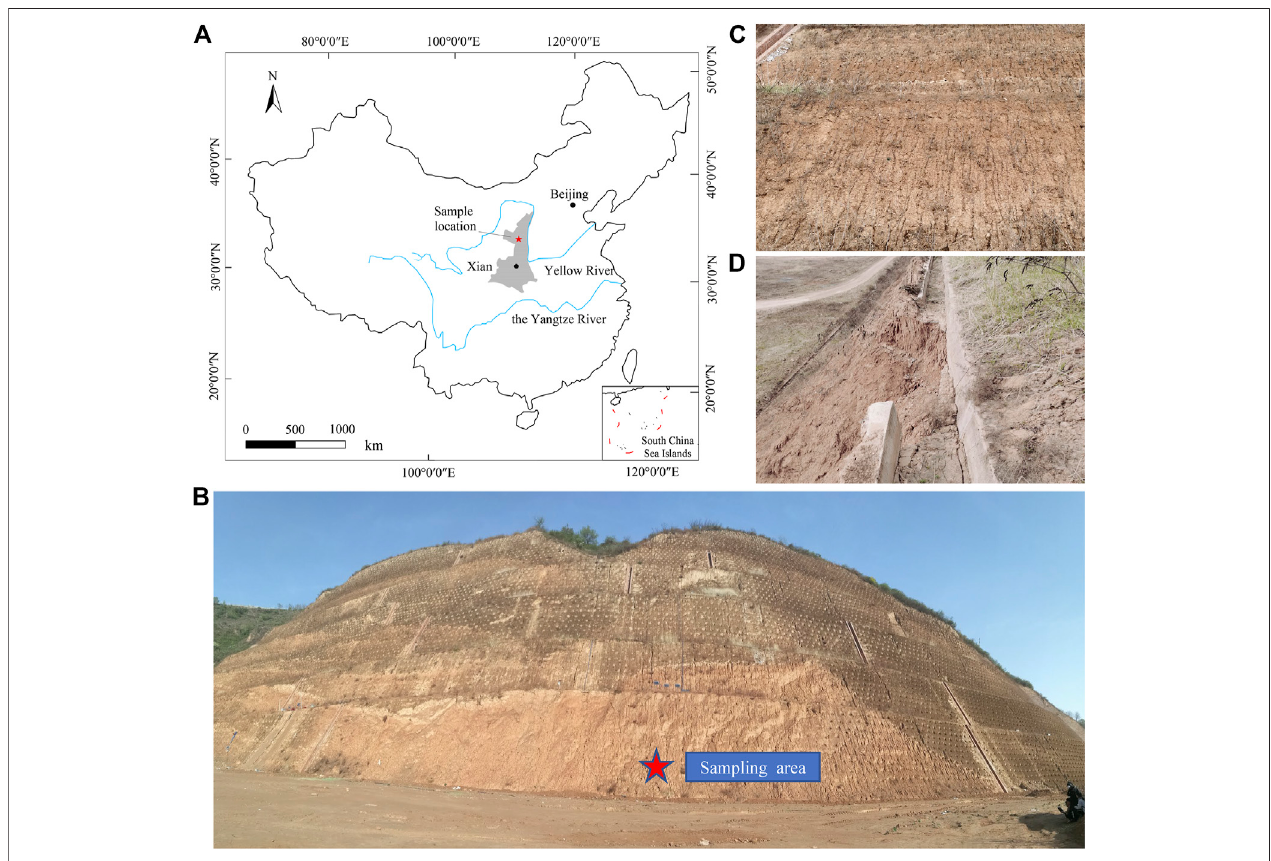
FIGURE 1 | Soil erosion on loess hillslope and sample location. (A) Geographical location of the sampling area; (B) panoramic image of the sampling area; (C) erosion gully on the hillslope; (D) drain collapsed owing to water erosion.